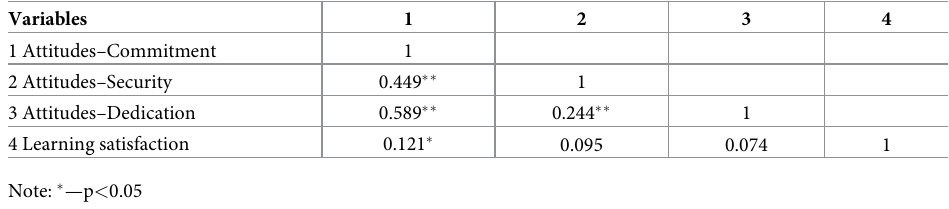
Table 4. Correlations between the attitudes toward nursing profession and learning satisfaction.